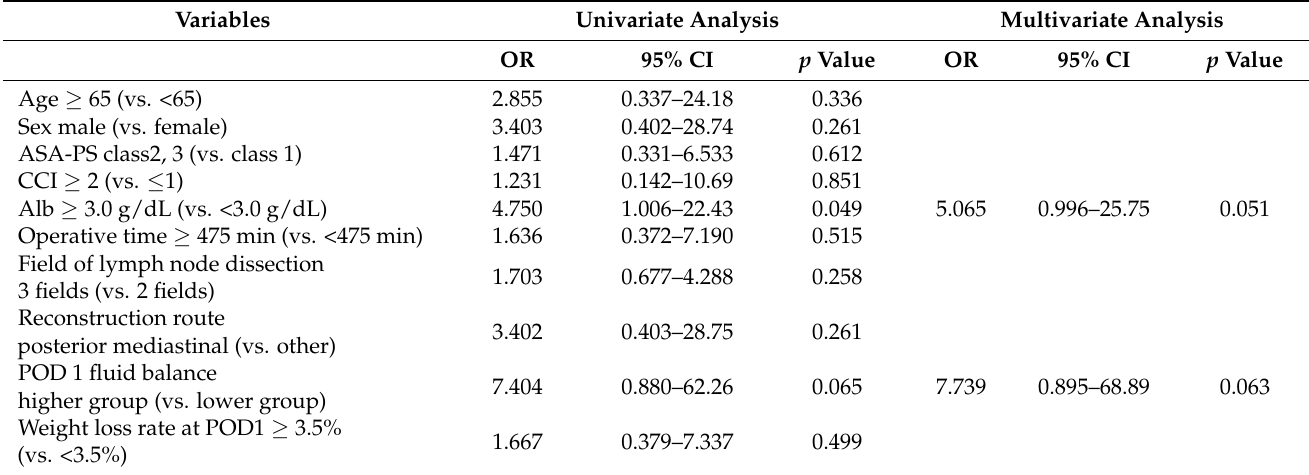
Table 6. Factors associated with anastomotic leakage after surgery by univariate and multivariate